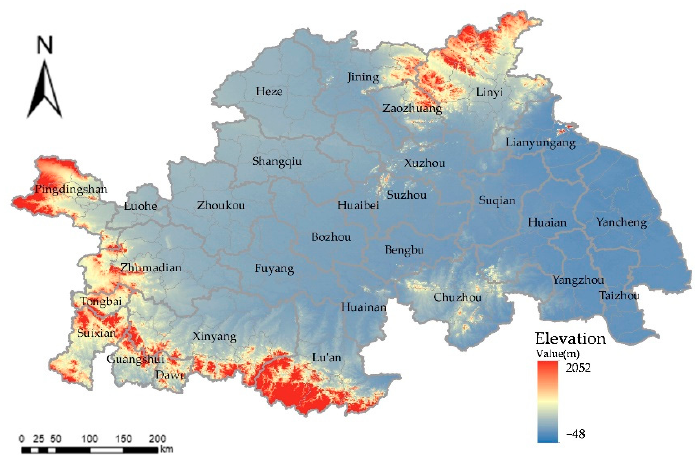
Water 2022 , 14 , x FOR PEER REVIEW Figure 2. Land use map of the Huai River Basin in 2010 and 2020. Figure 2. Land use map of the Huai River Basin in 2010 and 2020.